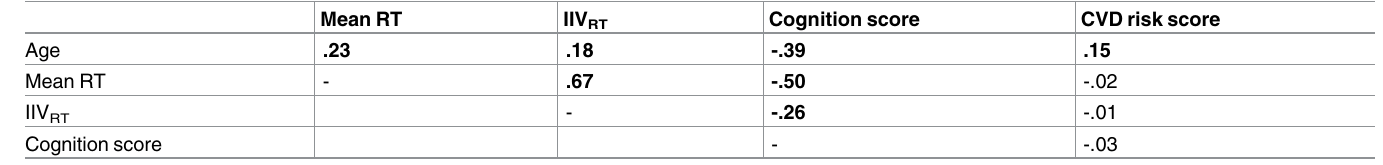
Table 2. Correlations between age, cognitive measuresCVD risk score.